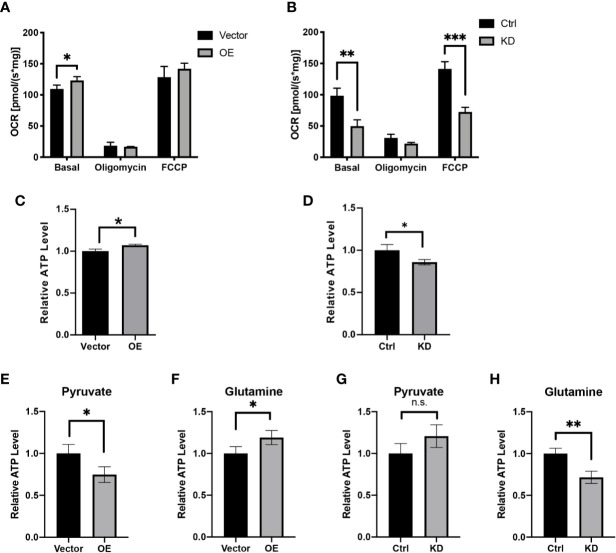
HPDL promotes mitochondrial respiration and ATP generation. (A, B) Oxygen consumption rate of HPDL OE (A) and KD (B) cells with theirs paired control cells. Basal, basal respiration with endogenous substrates solely. Oligomycin, respiration in the presence of ATP synthase inhibitor oligomycin (2.5 μM). FCCP, respiration in the presence of uncoupler FCCP (5 μM). (C, D) Relative ATP level of HPDL OE (C) and KD (D) cells with theirs paired control cells. (E–H) Relative ATP level of HPDL OE (E, F) and KD (G, H) cells with theirs paired control cells in different culture conditions. Cells were cultured in medium supplemented with 5 mM pyruvate only (E, G) or 4 mM glutamine only (F, H) for 12 h and subsequently the cellular ATP was measured. (*P < 0.05. **P < 0.01. ***P < 0.001. n.s., no significance.)